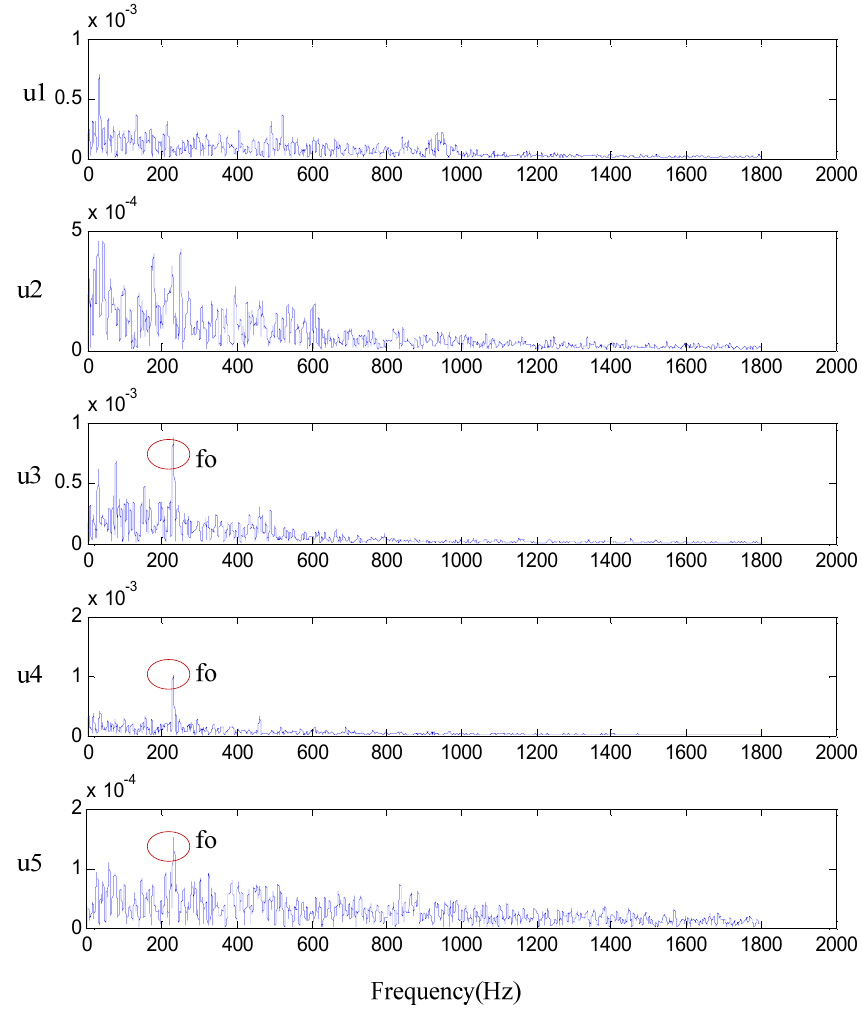
Figure 8. Envelope spectrum of arbitrary parameters guided-VMD.